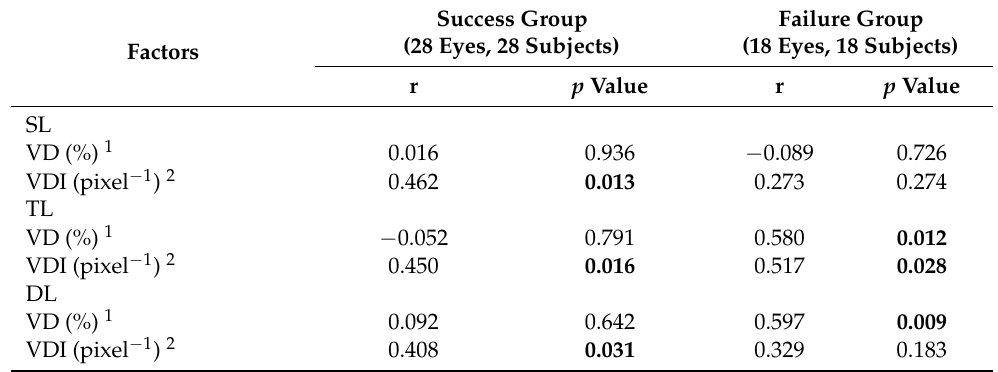
Table 3. Correlation between the vascular parameters and IOP.